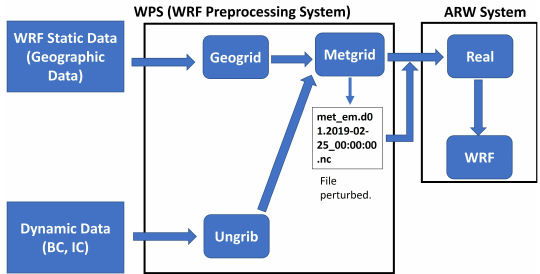
Figure 2. Structure of WRF model for running a real